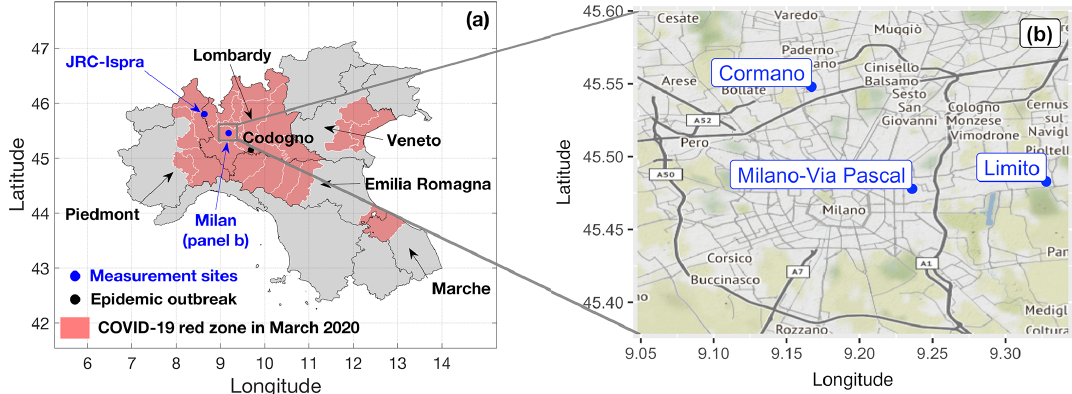
Figure 1. Northern Italy areas impacted by COVID-19 at the beginning of March 2020 (red zones) and location of the air pollution mea- surement sites in Ispra and Milan considered in this study. (b) © OpenStreetMap contributors 2020. Distributed under a Creative Commons BY-SA License.